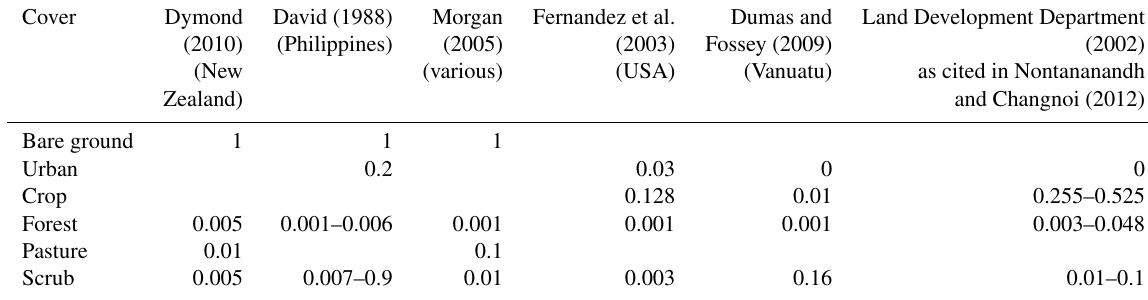
Table 8. C factors for general types of land cover compiled from various sources.